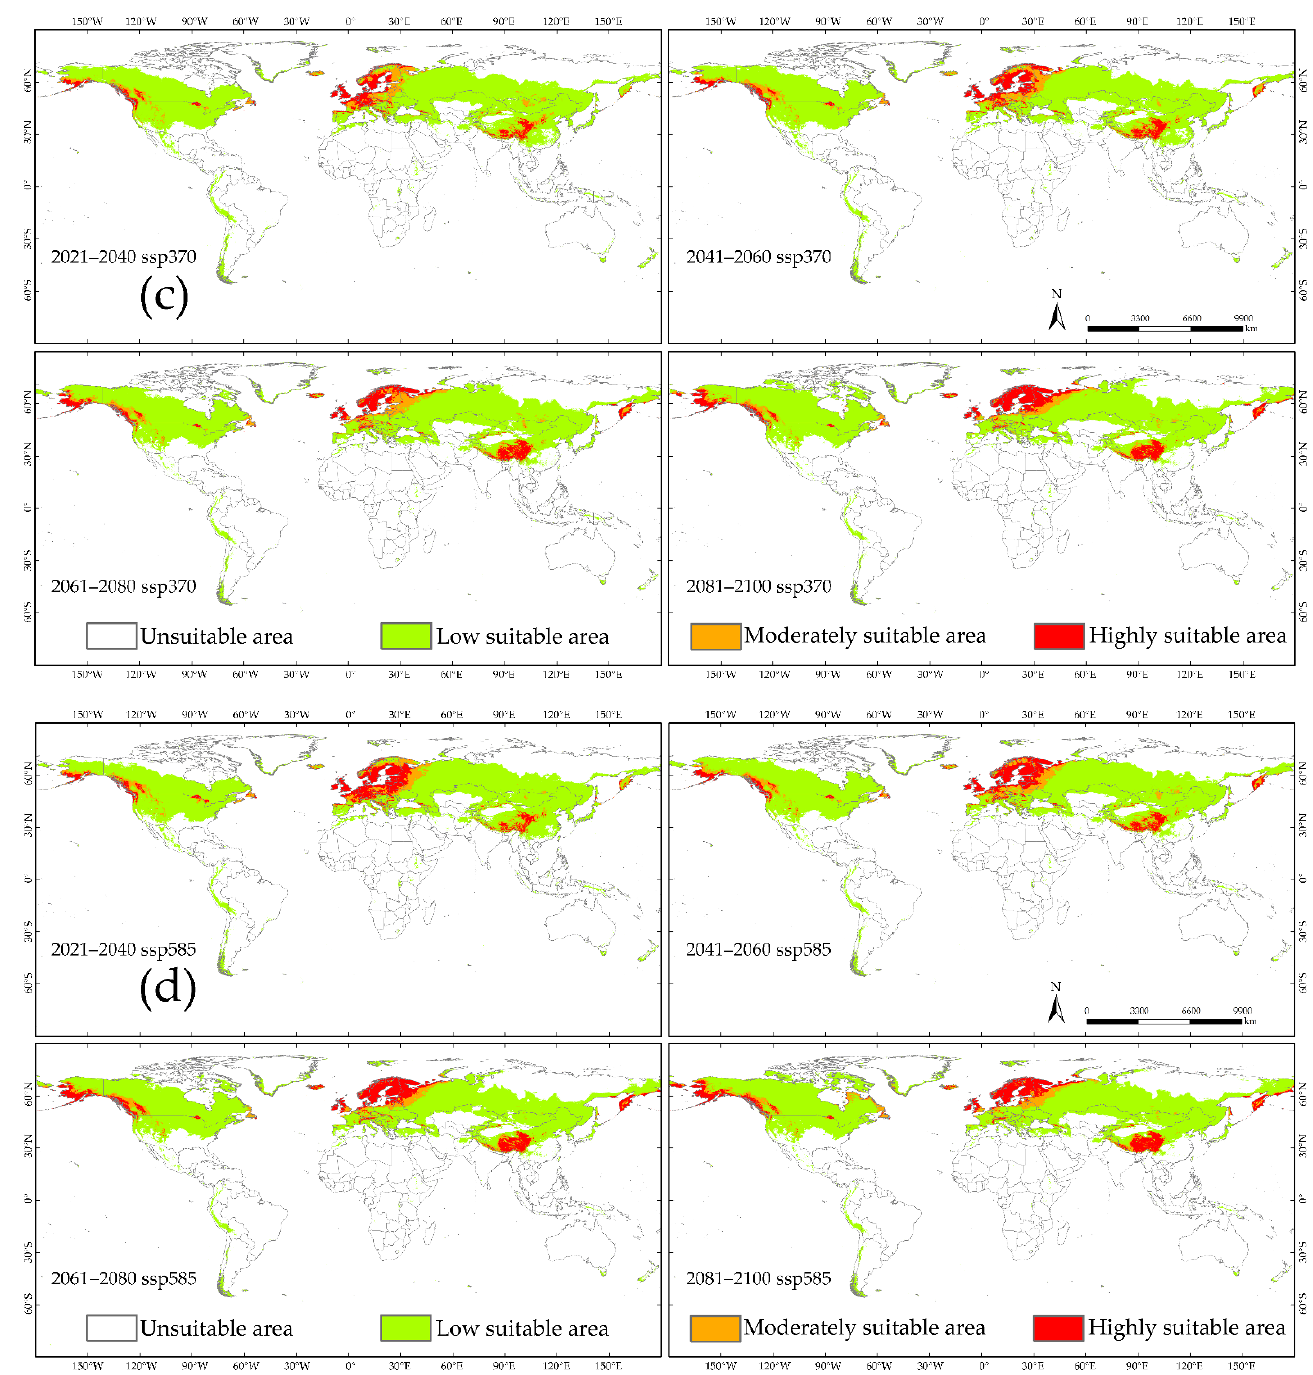
Figure 7. Predicted potential distribution of S. juvencus around the world under the future climate conditions during the periods of the 21st century under four CMIP6 climate scenarios and four shared socio-economic pathways: ( a ) ssp126; ( b ) ssp245; ( c ) ssp370; ( d ) ssp585.